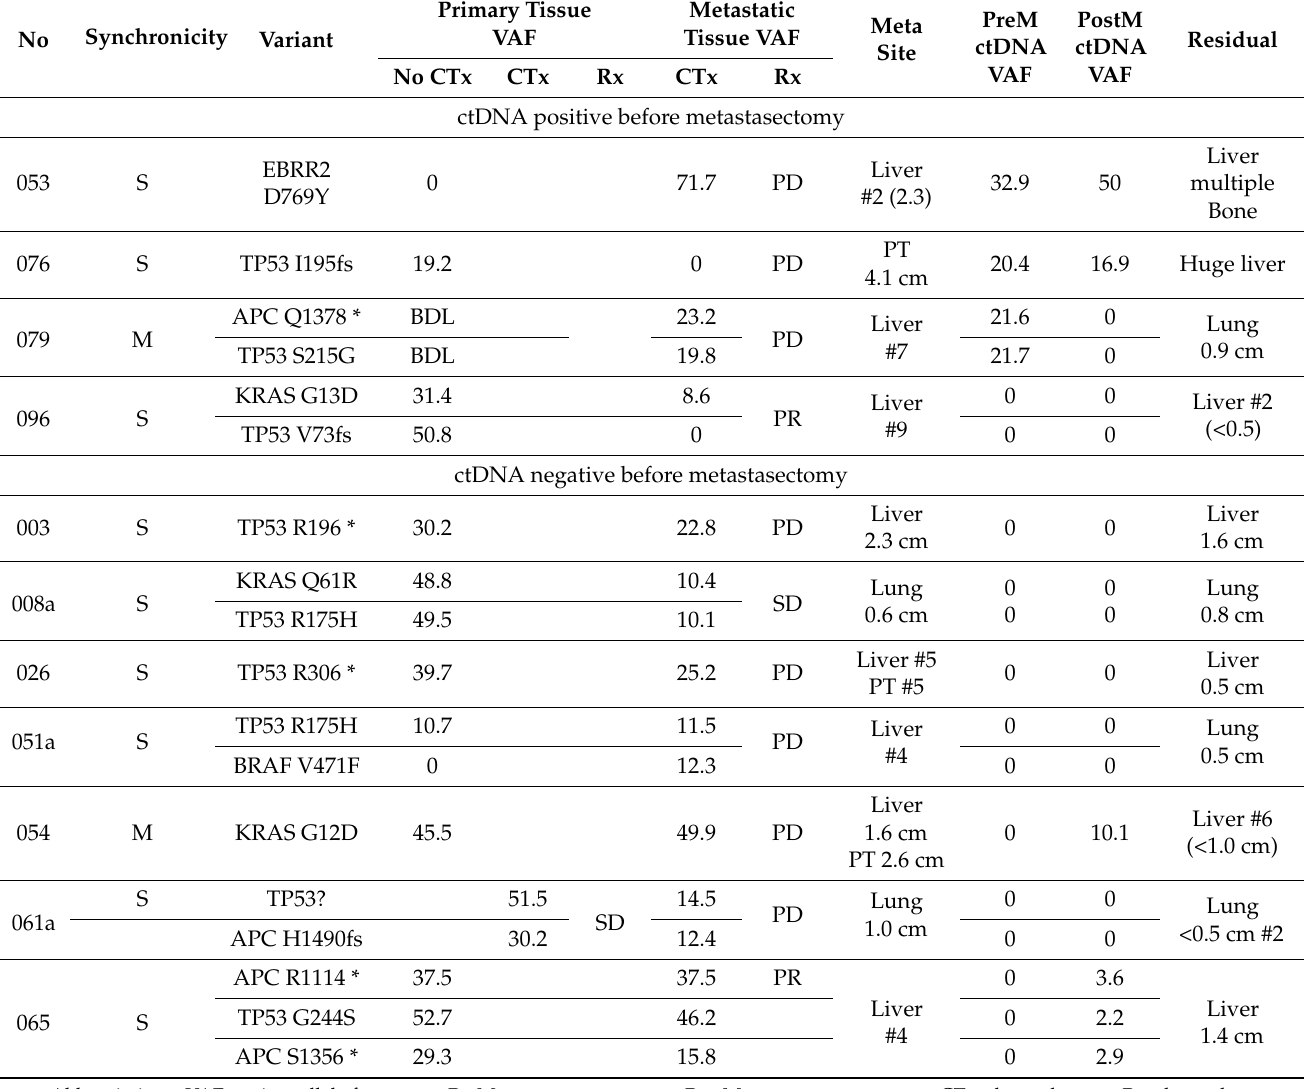
Primary Tissue Metastatic VAF Tissue